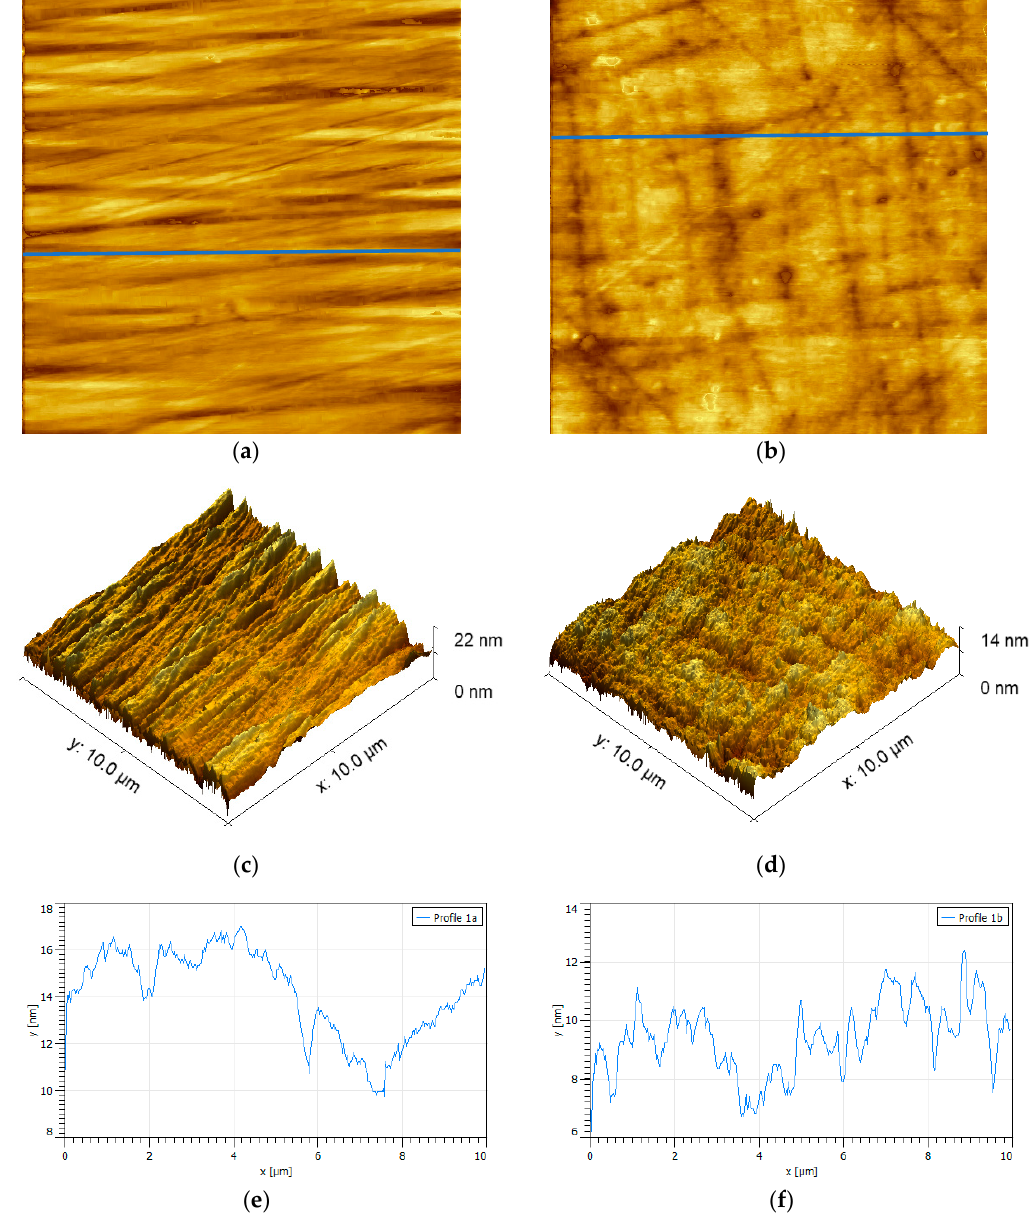
Figure 1. Surface {100} of polished pyrite ( a ) with 1 micron diamond paste and ( b ) with 0.25 micron diamond paste. Scan size is 10 × 10 μ m 2 . The 3D images of surfaces ( a ) and ( b ), respectively, are shown in ( c ) and ( d ). Height profiles corresponding to blue lines in ( a ) and ( b ), respectively, are shown in frames ( e ) and ( f ).